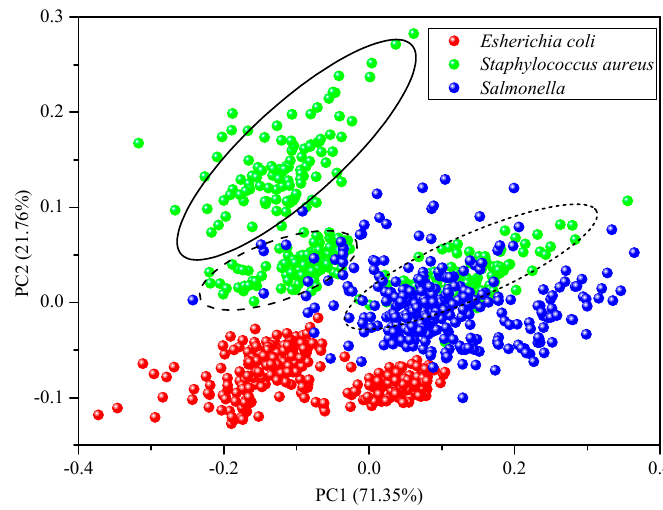
Figure 2. Score plot of bacterial colonies.